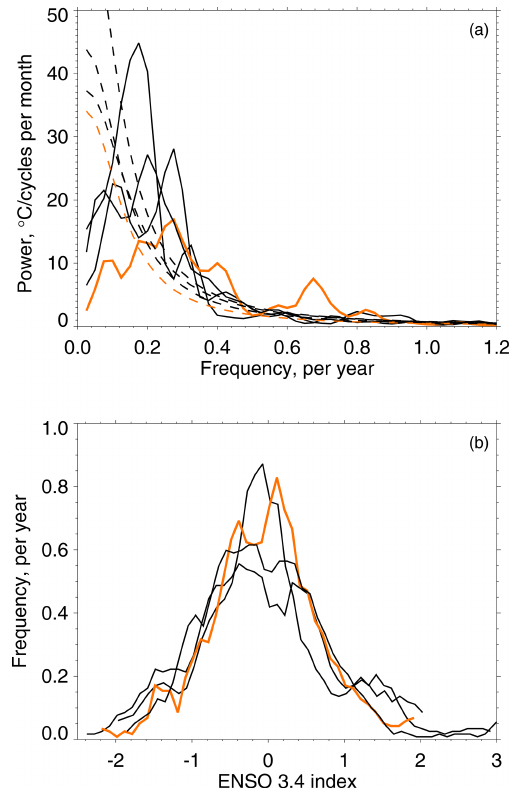
Figure 4. (a) The 1980–2018 Niño3.4 power spectra ( ◦ C/cyclesmonth − 1 ) calculated from the ERA5 data (orange) as well as from the three SOCOLv4 ensemble members (black). Dashed lines are the 95% significance levels based on an auto- regressive AR(1) process fitting. (b) Histogram of Niño3.4 temperature